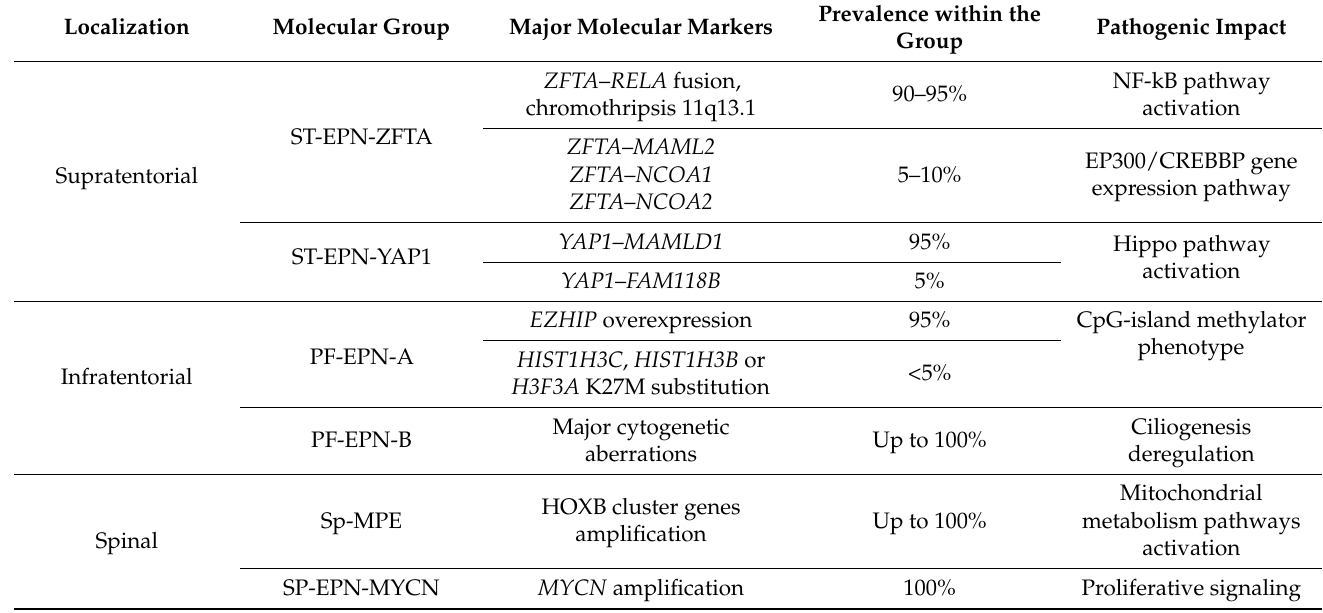
Table 1. Summary of major molecular markers of ependymal